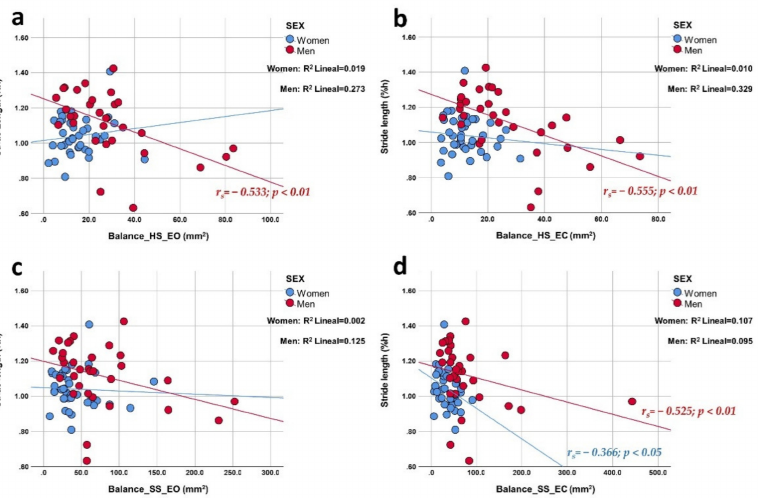
Figure 1. Correlation plots of stride length compared to balance area in each of the tests. Each image shows the correlations obtained distributed by sex. The upper part of the figure shows the results for a hard surface with eyes open (panel ( a ); linear R 2 women: 1.9%; men: 27.3%) and closed eyes (panel ( b ); linear R 2 women: 1.0%; men: 32.9%); the lower part shows the results for a soft surface with open eyes (panel ( c ); linear R 2 women: 0.2%; men: 12.5%) and closed eyes (panel ( d ); linear R 2 women: 10.7%; men: